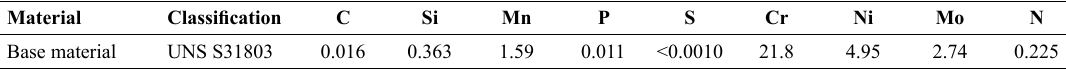
Table 1. Chemical composition of the duplex as received material.